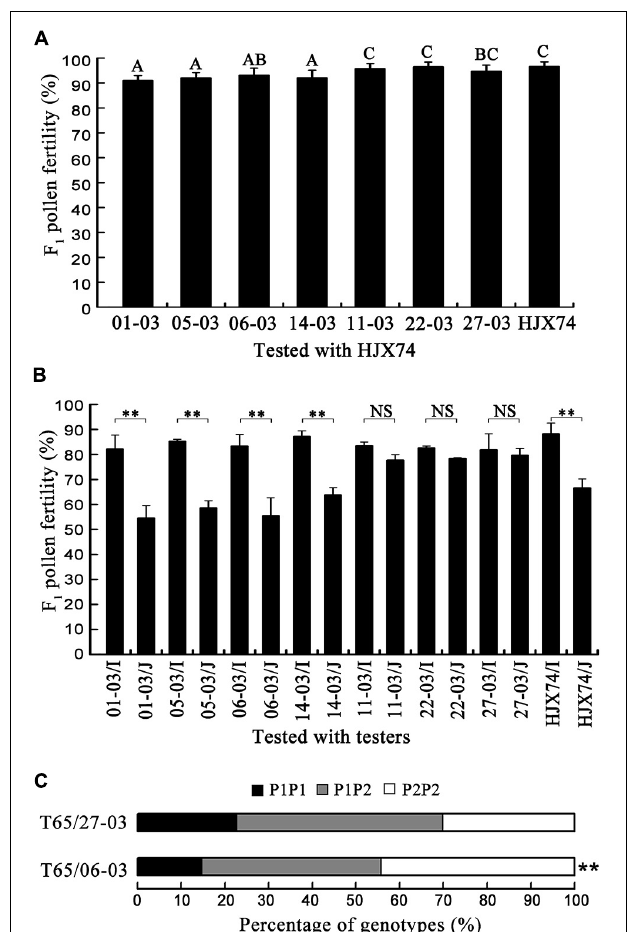
FIGURE 2 | Genotypes and genetic effects of the Sc gene on chromosomal substitution segments of SSSLs with the HJX74 genetic background. (A) Pollen fertility of F 1 hybrids from crosses between SSSLs and HJX74. (B) Pollen fertility of F 1 hybrids from crosses between SSSLs and testers. I, indica testers; J, japonica testers. (C) Segregation ratios of Sc genotypes in F 2 populations from crosses between SSSLs and T65. P1P1, Genotype of T65 ( S j / S j ); P1P2, Heterozygous genotypes; P2P2, Genotypes of SSSLs. ∗∗ , Significant difference at 0.01 probability level. NS, No